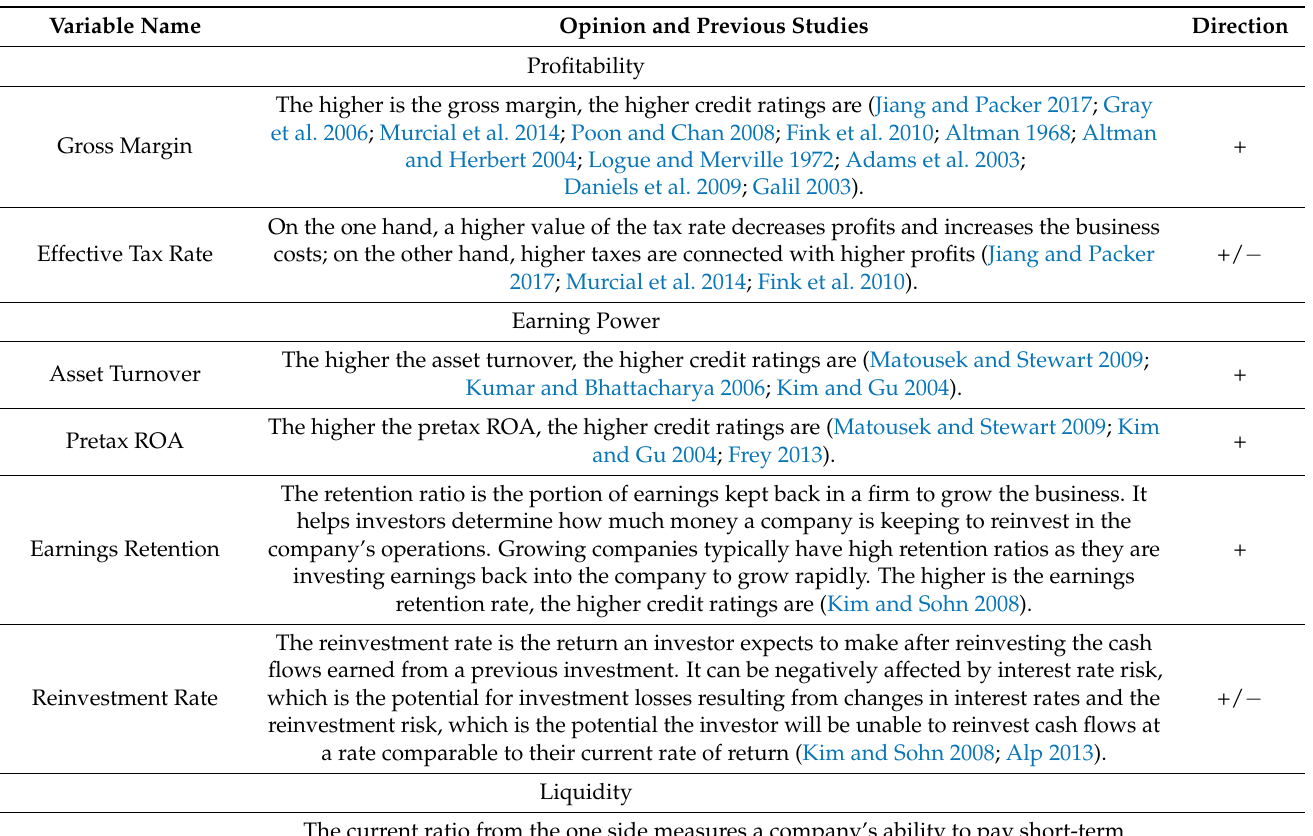
Table 5. Description of the impact of the financial factors on credit